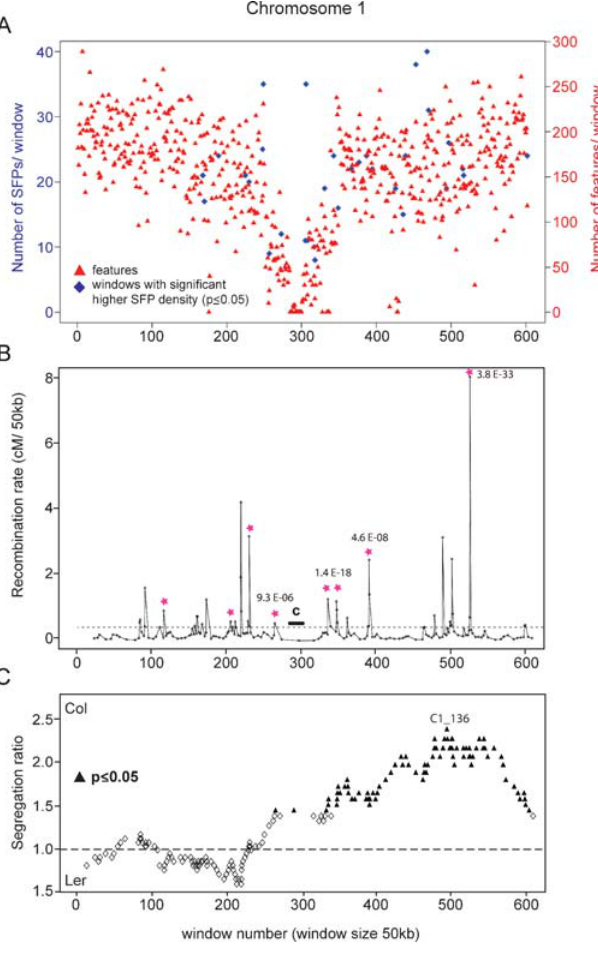
Figure 1. Chromosome-Wide Distribution of SFPs, Recombination Rate, and Segregation Ratio Figures for the remaining four chromosomes are included in Supporting Information. (A) Feature and SFP-distribution on Chromosome 1. The chromosome was divided into 50-kb windows. Red triangles represent number of features per window. The number of SFPs per feature in each window was compared to the number of SFPs per feature in all windows using Fisher’s exact test. A p -value was calculated and a Bonferroni multiple testing correction was applied to test for significance. Blue diamonds indicate windows with significantly higher SFP density ( p -value (cid:1) 0.05). (B) Variation of recombination rate along Chromosome 1. Recombination rate was calculated as the genetic distance (in cM/50 kb) between pairs of neighboring informative SFP markers and plotted versus the average physical distance between the same markers. Pink stars indicate hot spots of recombination that exceed the expected recombination rate significantly ( p -value (cid:1) 0.001, Chi-square test, after Bonferroni-correc- tion). P -values are depicted next to the peaks. All values were normalized to 50 kb. Average genome-wide recombination rate is marked as a dotted horizontal line. The location of the centromere is marked with a black bar. (C) Segregation distortion of SFP markers on Chromosome 1. Segregation ratios of genotypes for each informative SFP marker were calculated across 98 RILs and plotted along the chromosome. The vertical scale shows allele ratios. The expected equal distribution of Col and L er alles accross 98 lines should result in a ratio of 1 and is depicted as a dotted horizontal line. SFP markers with allele ratios above the line indicate segregationdistortiontowardstheColallele,SFPmarkerswithalleleratios below the line indicate segregation distortion towards the L er allele. Empty diamonds represent SFP markers with no significant segregation distortion from the expected ratio of 1 between Col and L er genotypes. Filled triangles represent markers that show a significant ( p (cid:1) 0.05, Fisher’s exact test) segregation distortion towards the Col genotype. DOI: 10.1371/journal.pgen.0020144.g001